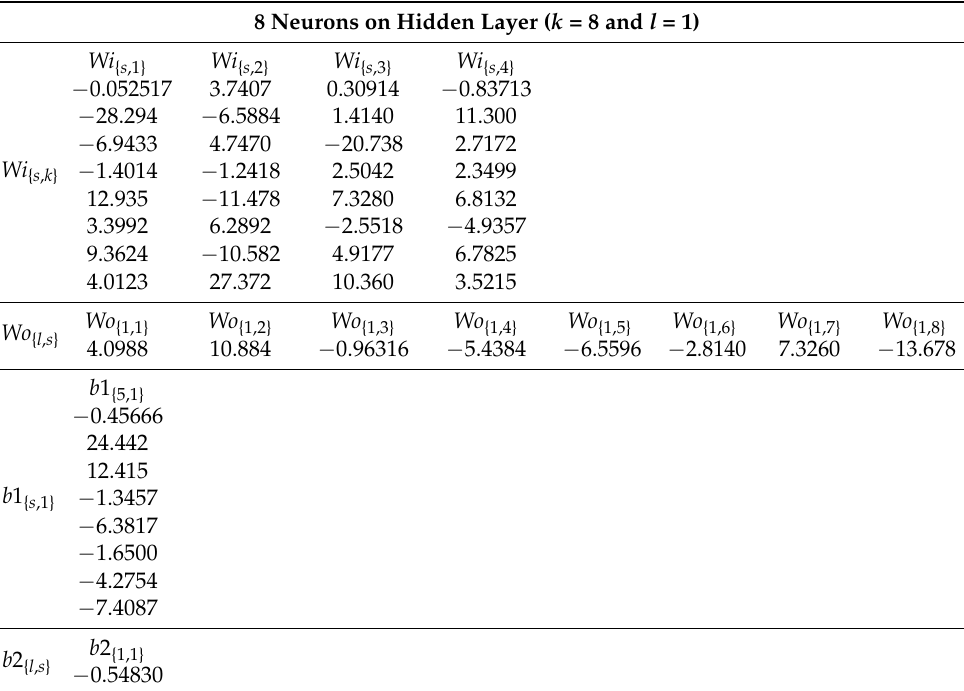
Table A1. Weights and biases for the ANN model predicting adiponectin